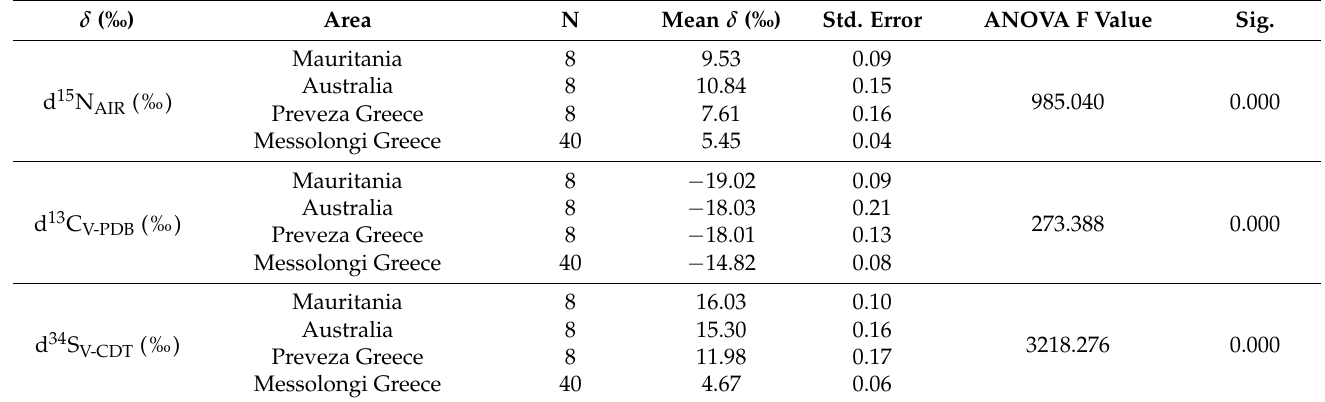
Table 2. One way ANOVA analysis results (mean values and standard